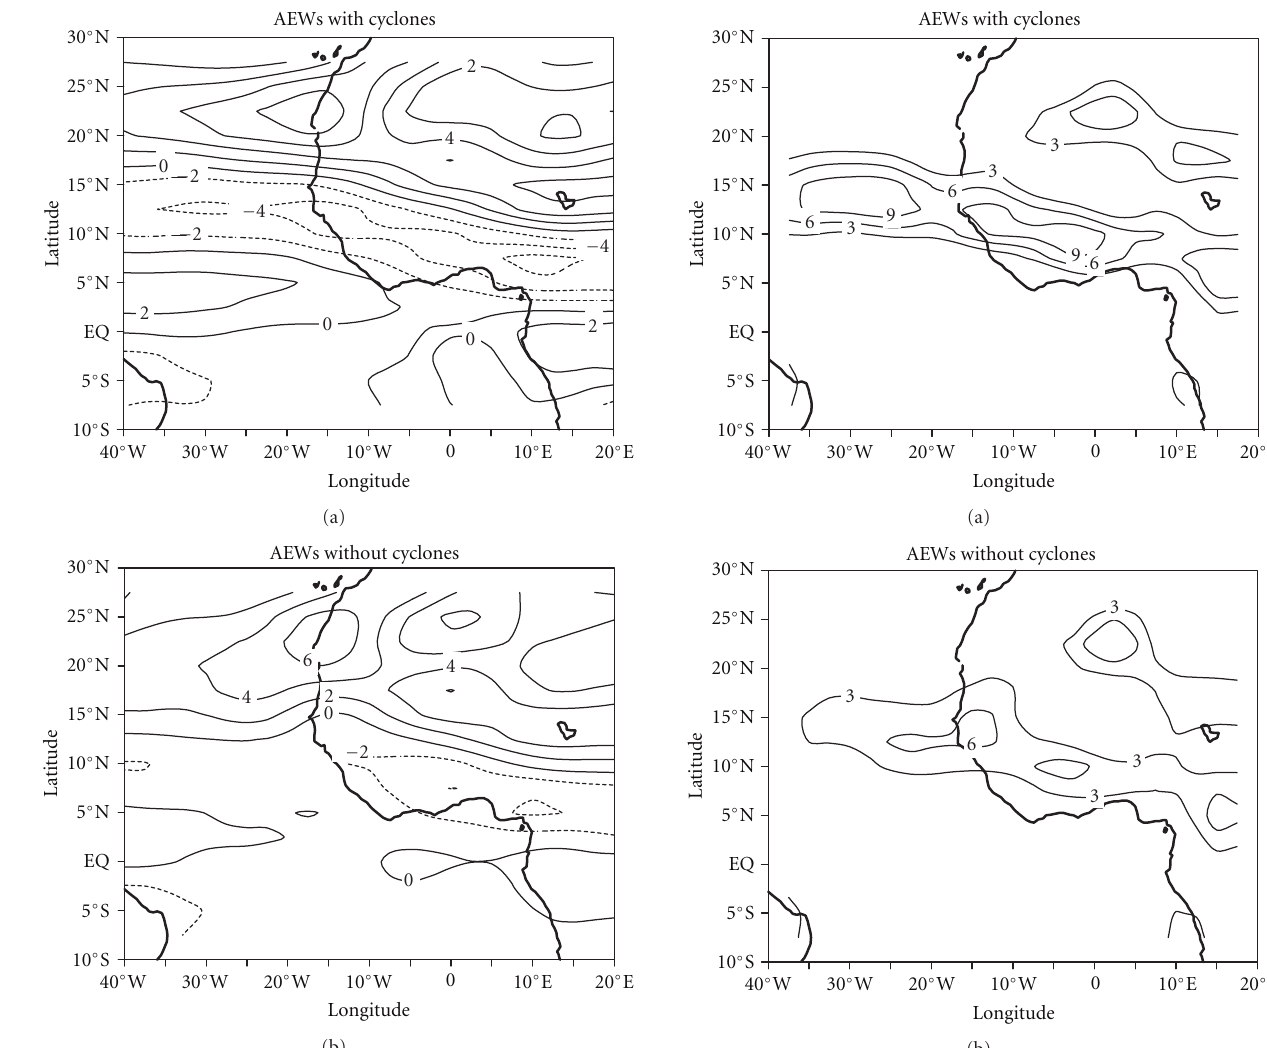
Figure 6: Relative Vorticity at 850hPa for AEWs associated with cyclones (a) and for non-developing AEWs (b). Only values greater than or equal to zero are contoured. Unit is 10 − 6 s − 1